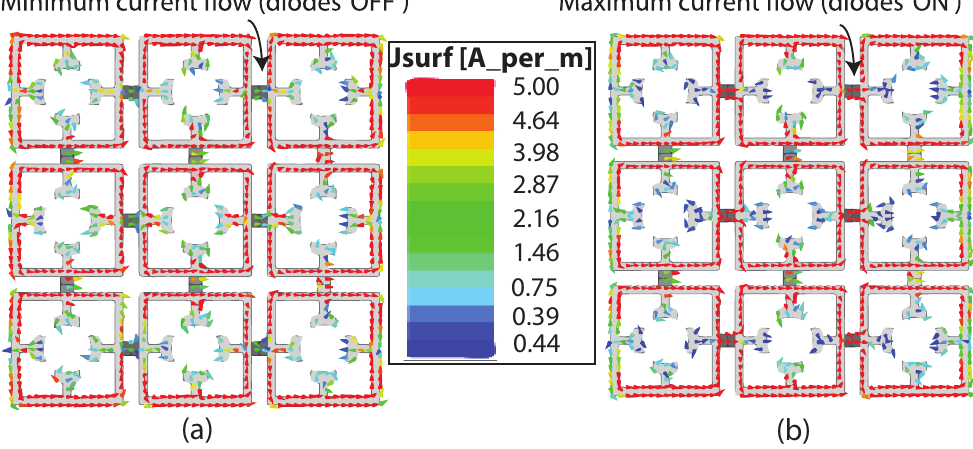
Figure 8. Surface current distribution of the reconfigurable FSS in the TE mode with ( a ) a PIN diode in the “OFF” state at 11 GHz and ( b ) a PIN diode in the “ON” state at 6.6 GHz.